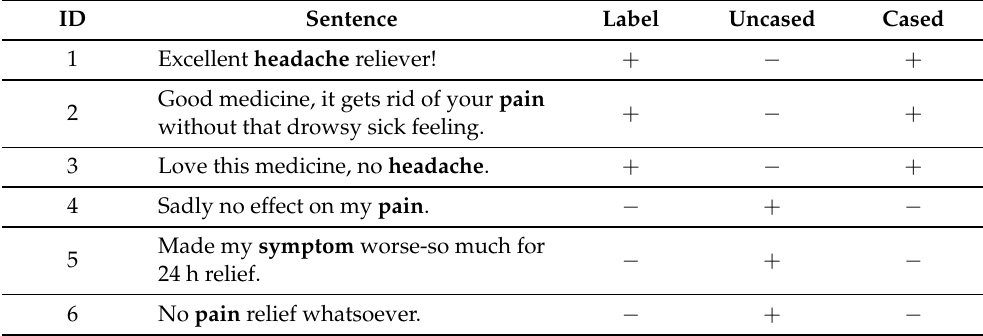
Table 3. A sample of sentences incorrectly classified by the uncased model but correctly classified by the cased